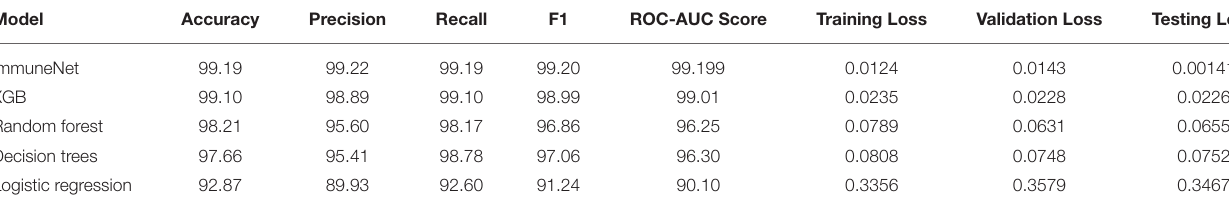
TABLE 10 | Comparison of models based on respective evaluation metrics for CIC Bell DNS 2021. Model